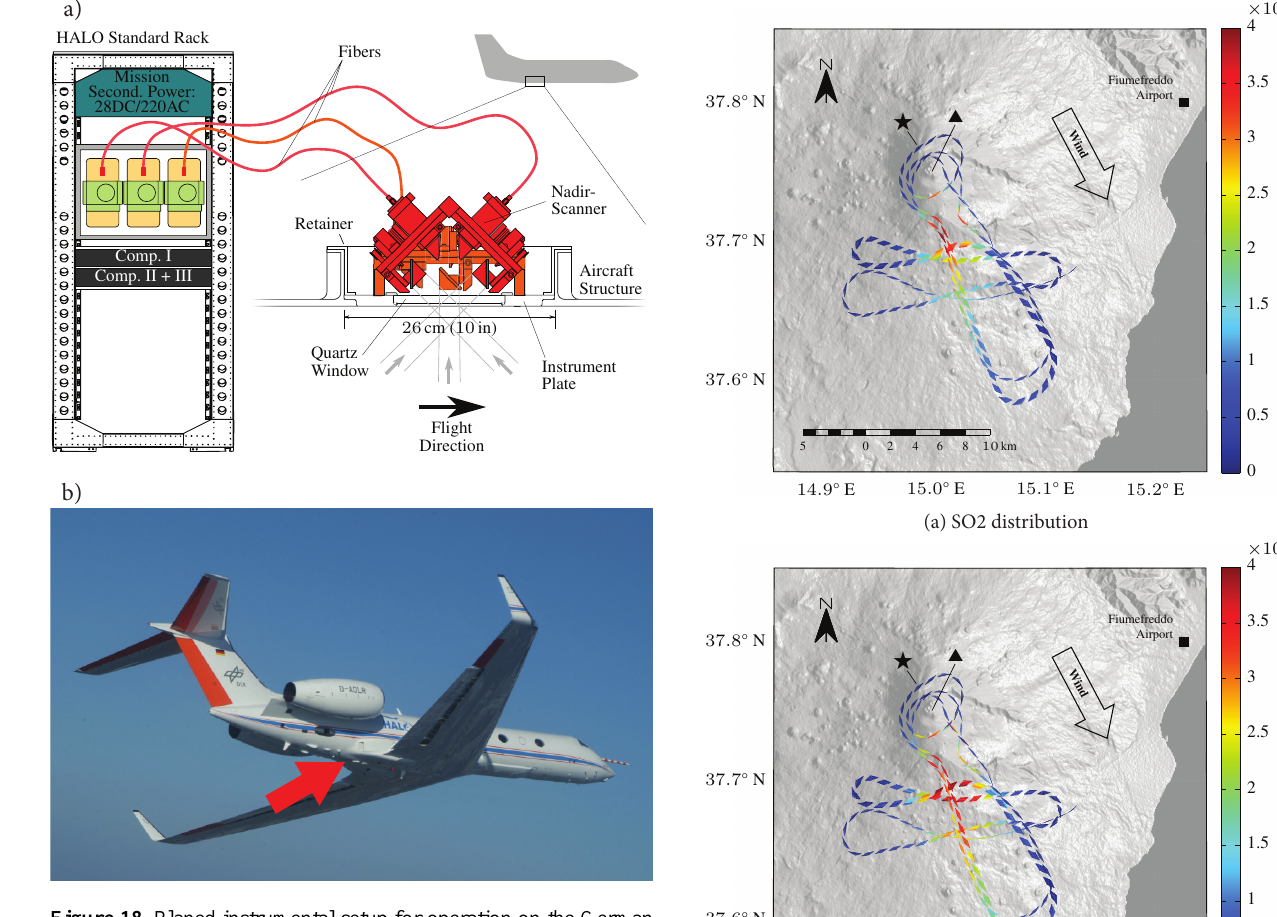
Figure 18. Planed instrumental setup for operation on the German research aircraft HALO: (a) Schematic showing the three whiskb- room scanners installed on a HALO instrument plate. The whiskb- room scanners are pointed to different directions in order to enable the recording of vertical profiles; one in nadir direction and the other two tilted by ± 45 ◦ in flight direction. HAIDI’s instrument rack and additional computers for data acquisition will be installed in a HALO standard rack. (b) Picture of HALO in flight (DLR, 2013), showing the preferred location for HAIDI in the rear (red arrow).